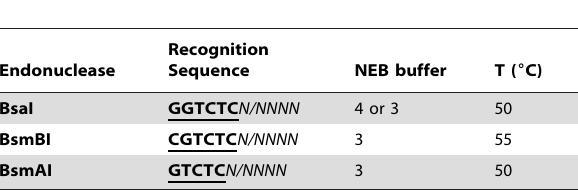
Table 1. Buffer and temperature preferences of the BsmBI/ BsaI/BsmAI